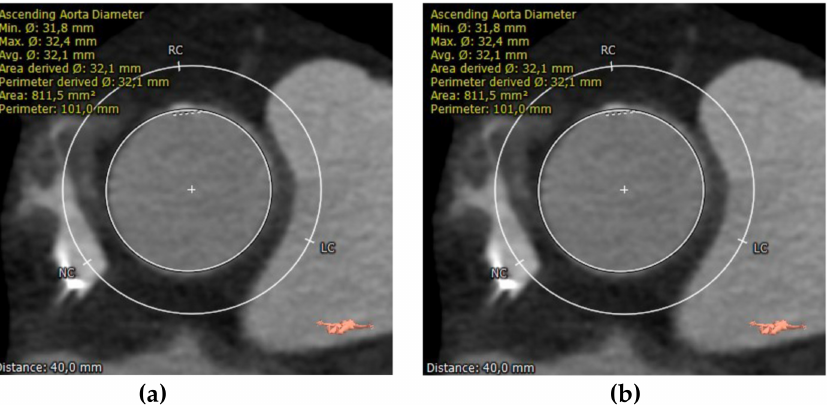
Figure 7. ( a ) Sinotubular junction and ( b ) proximal ascending aorta evaluated by CT for TAVI.